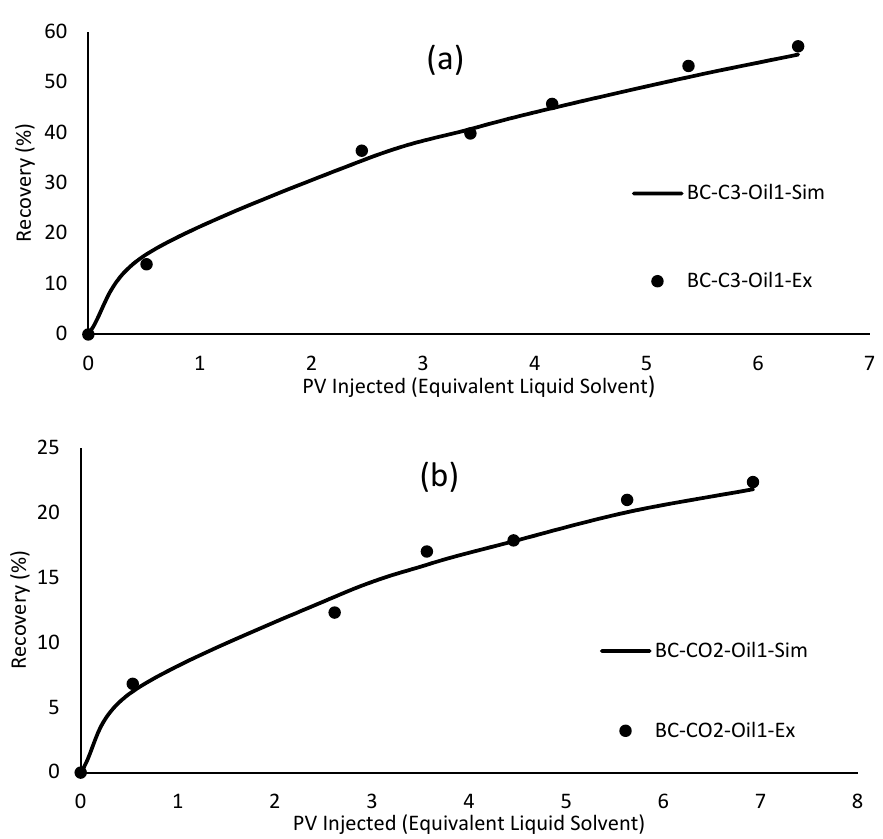
Figure 8. History matching results in the base case scenario with ( a ) C 3 H 8 , and ( b ) CO 2 .